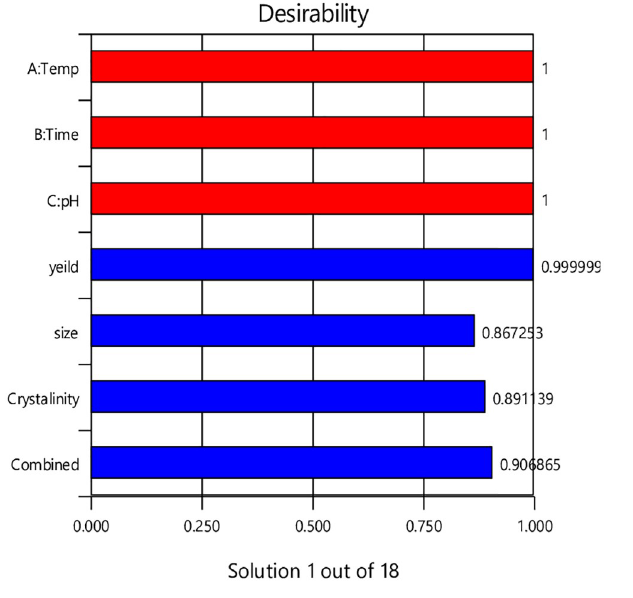
Fig 16. Desirability bar